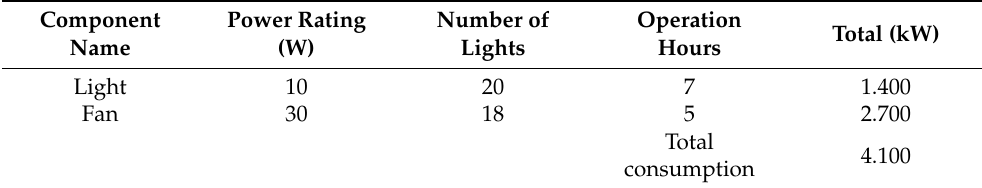
Table 2. Summary of load consumption for a typical small primary school building while the effect of a thin-film coating is considered.